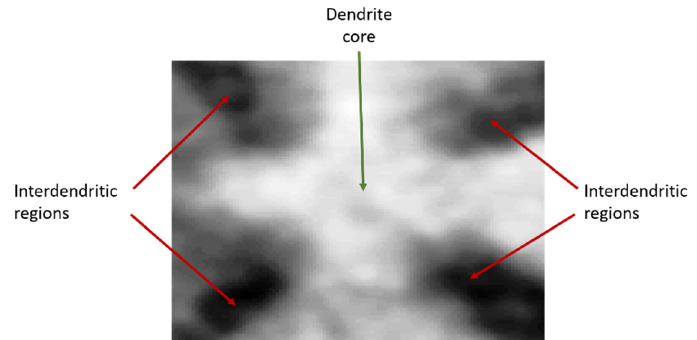
Figure 3. An example of a template for correlation, illustrating clearly a distinguishable dendritic core from surrounding interdendritic regions. As cores are forming in a near steady-state condition they maintain the same shape across an array. Therefore, any dendrite from within the array can be used as a template for the normalised cross-correlation (NCC).